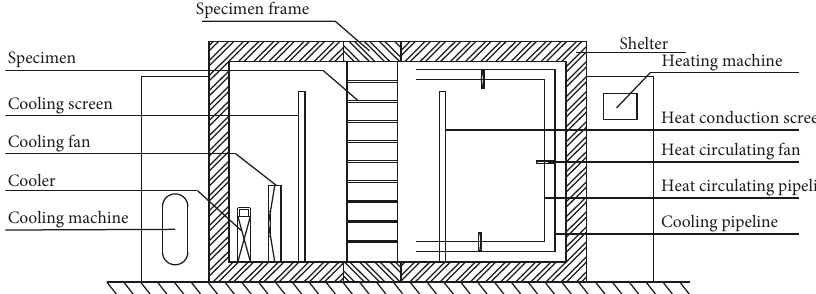
Figure 10: Schematic of the test machine for the joggled joint block wall thermal test.